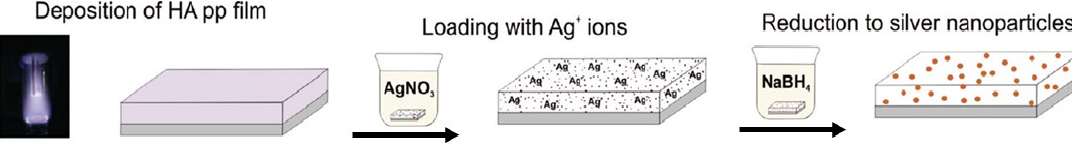
Figure 4. Schematic of the preparation of silver nanoparticles loaded films via first loading silver ions into an amine rich plasma polymer film deposited from the vapour of heptylamine (HA pp) followed by a reduction to silver nanoparticles.